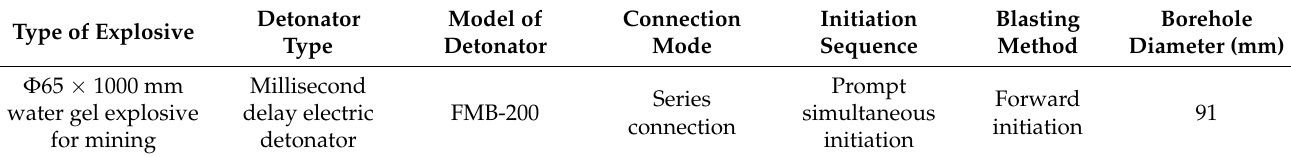
Table 6. Parameters of blasting explosives.